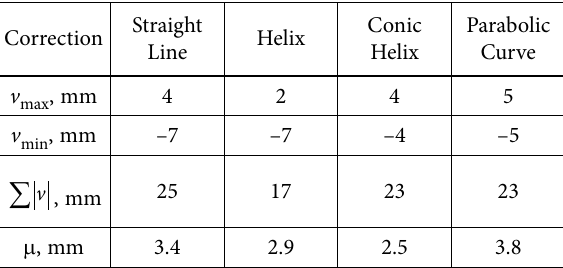
Table 4. Corrections and the accuracy of the approximation Straight Conic Parabolic Correction Helix Line Helix